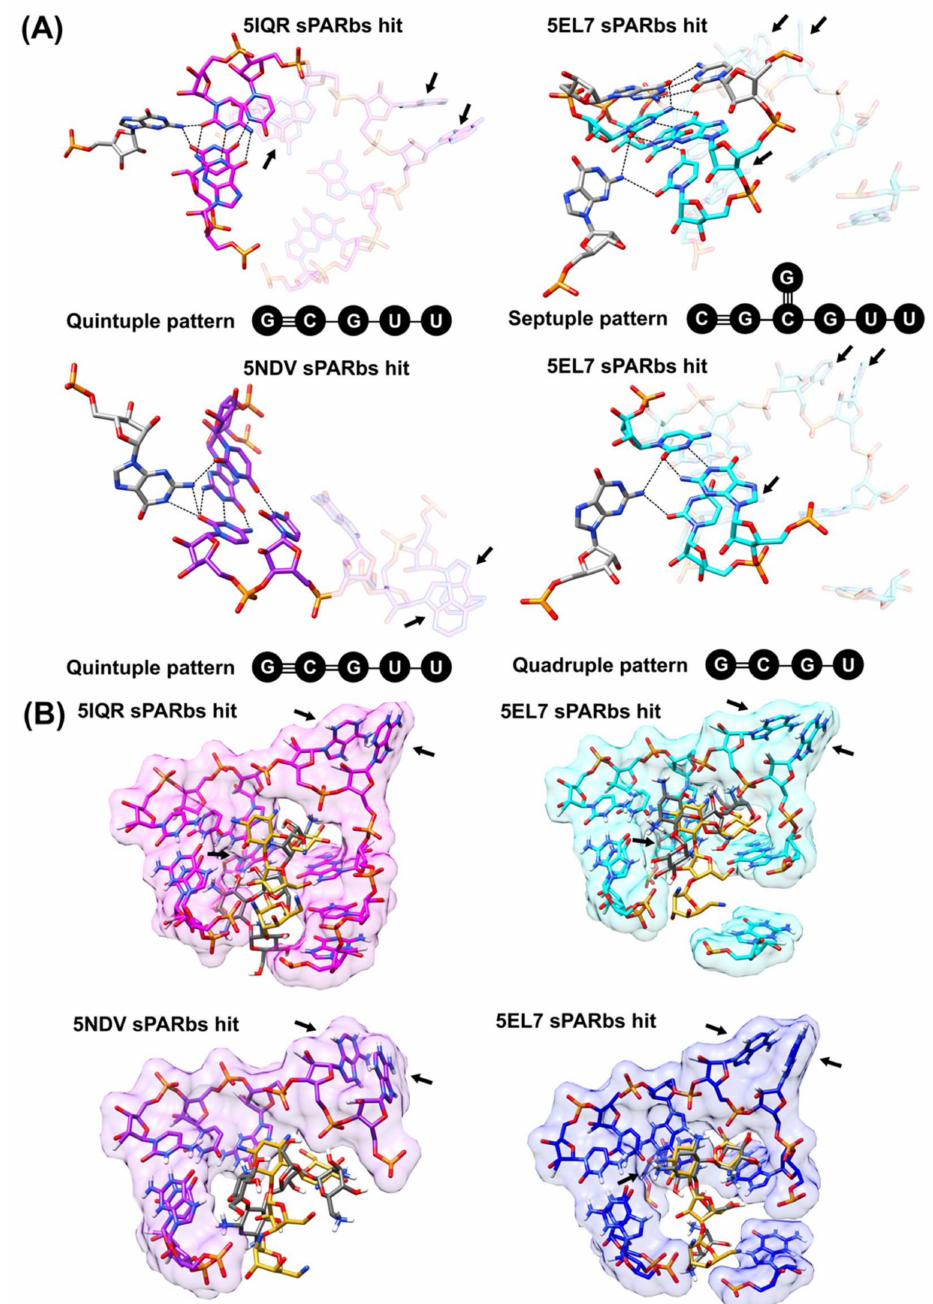
Figure 7. Annotation of functional (paromomycin-binding) sites in RNA structures from PDB by COGNAC. ( A ) The components of binding sites from RNA structures (PDB ID: 5IQR, 5EL7, and 5NDV) that involve in the networks of hydrogen-bonded base interactions are colored in magenta, cyan, and purple, respectively; otherwise, they are transparent. The nucleotides that are not components of binding sites but are involved in the interaction networks are colored in grey. The networks of hydrogen-bonded base interactions are represented by the dashed lines. ( B ) The surface renderings represent the possible binding pockets formed. The predicted binding pose (grey paromomycin) and the experimentally determined binding pose (gold paromomycin) are shown in those binding pockets. The hydrogen, nitrogen, oxygen, and phosphate atoms are colored in white, blue, red, and orange, respectively, on the stick structures in ( A , B